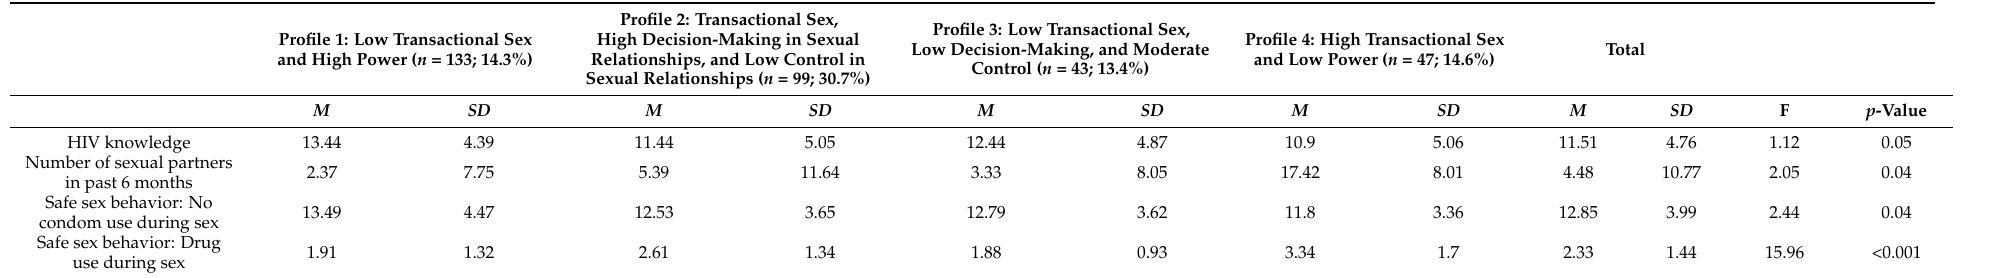
Table 4. Mean-level group differences between latent profile groups ( N =